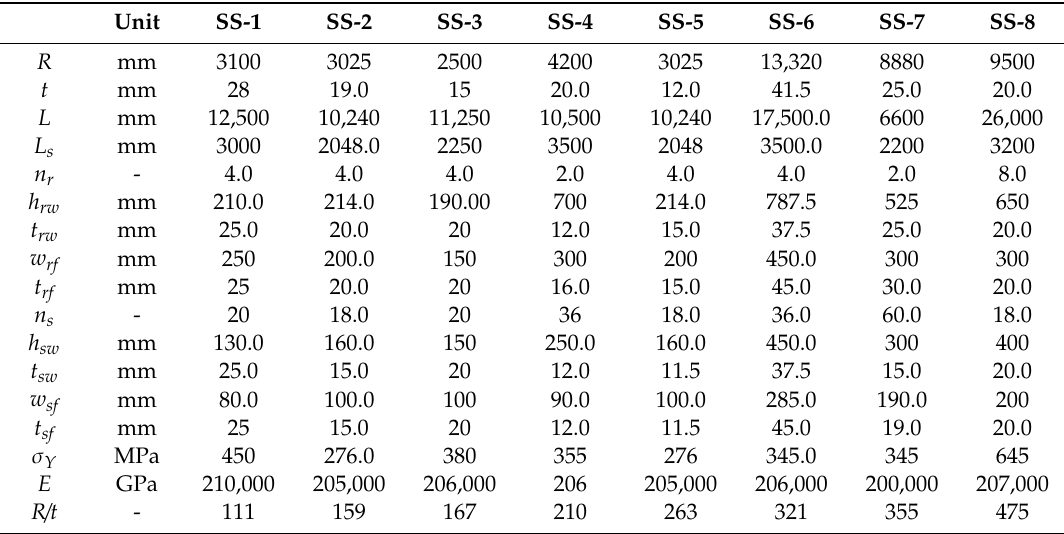
Table 8. Material properties and dimensions of the stringer-sti ff ened